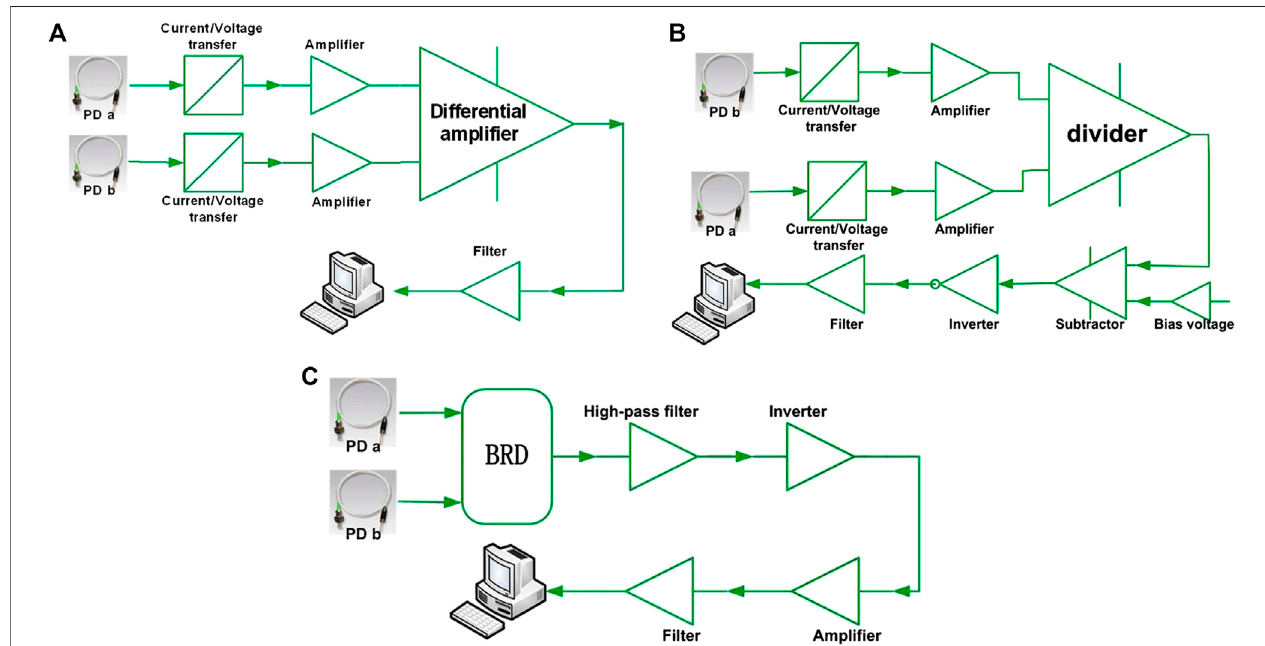
FIGURE 4 | Schematic diagram of the (A) subtraction demodulation circuit (B) division demodulation circuit (C) BRD demodulation circuit.